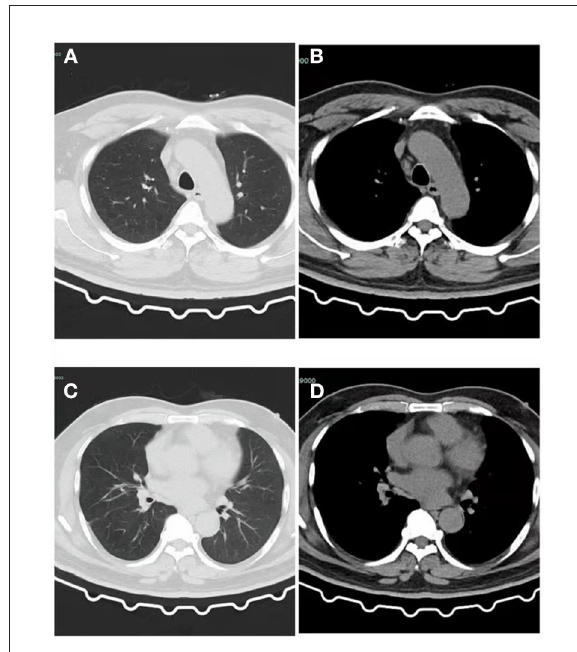
FIGURE4 CT of the patient after recovery. (A) Lung window: The patchy high-density shadow in the upper lobe of the left lung have been completely absorbed, and a few cord-like shadows can be seen with clear edges. (B) Mediastinal window: No obvious exudative lesions in the left upper lobe. (C) Lung window: The patchy high-density shadow and pleural effusion in the lower lobe of the left lung have been completely absorbed, and a few cord-like shadows can be seen with clear edges. (D) Mediastinal window: No obvious exudative lesions in the left lower